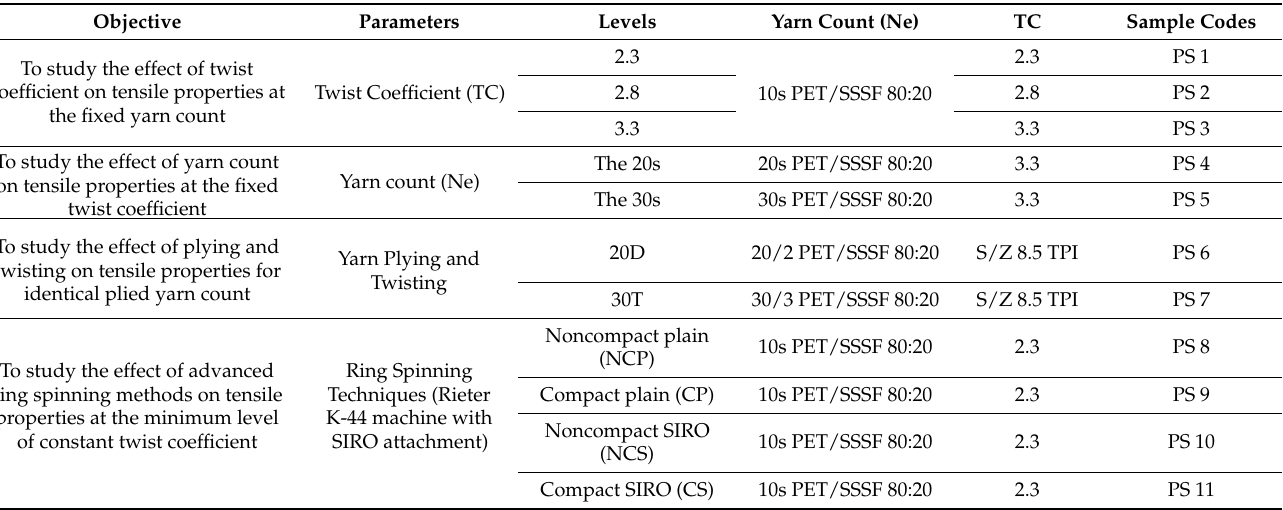
Table 3. Design of experimental plan.